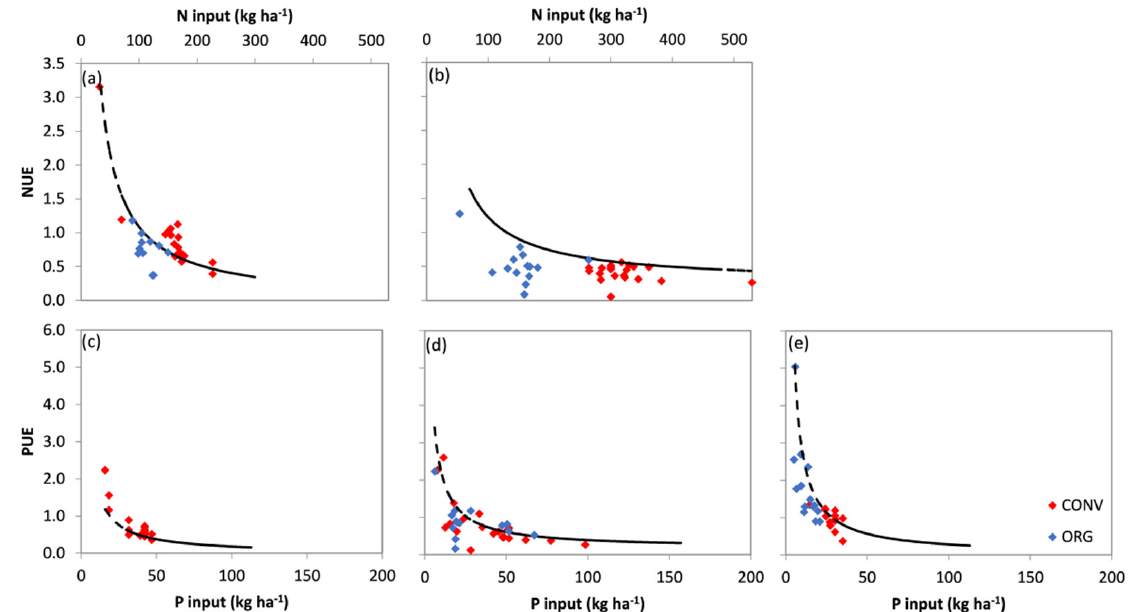
Figure 4. Relationship between nitrogen ( a , b ) and phosphorus ( c – e ) fertilisation levels and the output-to-input ratio for winter wheat ( a , c ), maize ( b , d ), and soybean ( e ). The black line represents the interpolated hyperbolic model from the long-term experiment (LTE), and the points represent RF observations clustered for different agronomic practices, i.e., conv: conventional agriculture (red points) and org: organic agriculture (blue points). The LTE-based model was dotted outside the LTE original range.